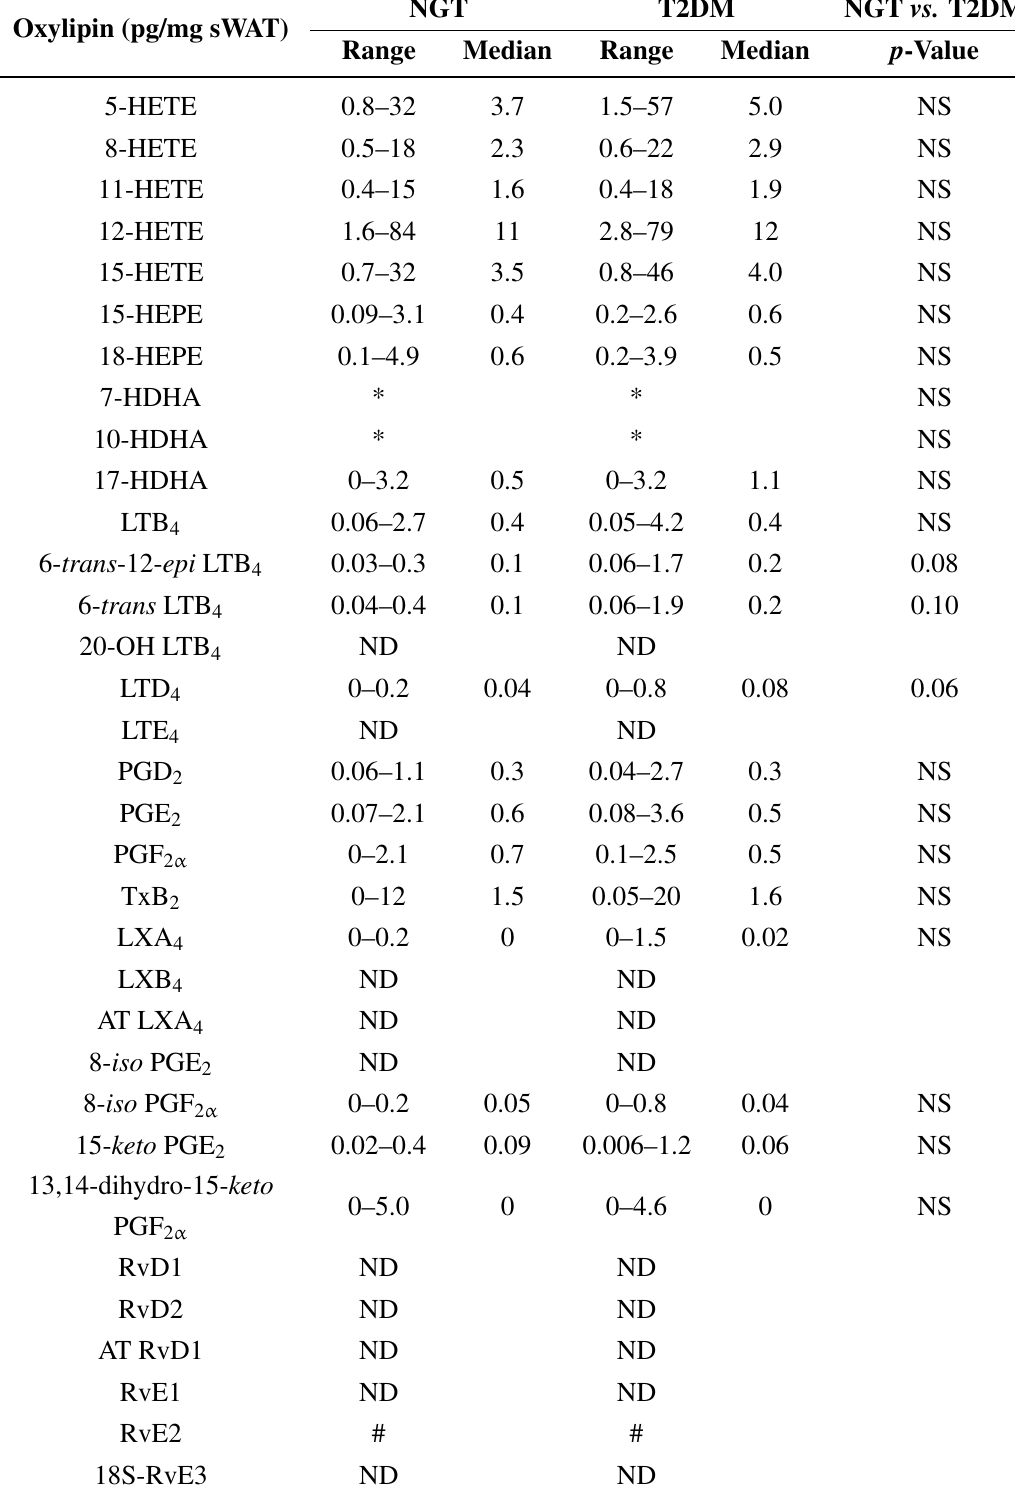
Table 2. Oxylipins in white adipose tissue (sWAT) of normal glucose tolerance (NGT) versus type 2 diabetes mellitus (T2DM) obese women. NGT versus T2DM values were